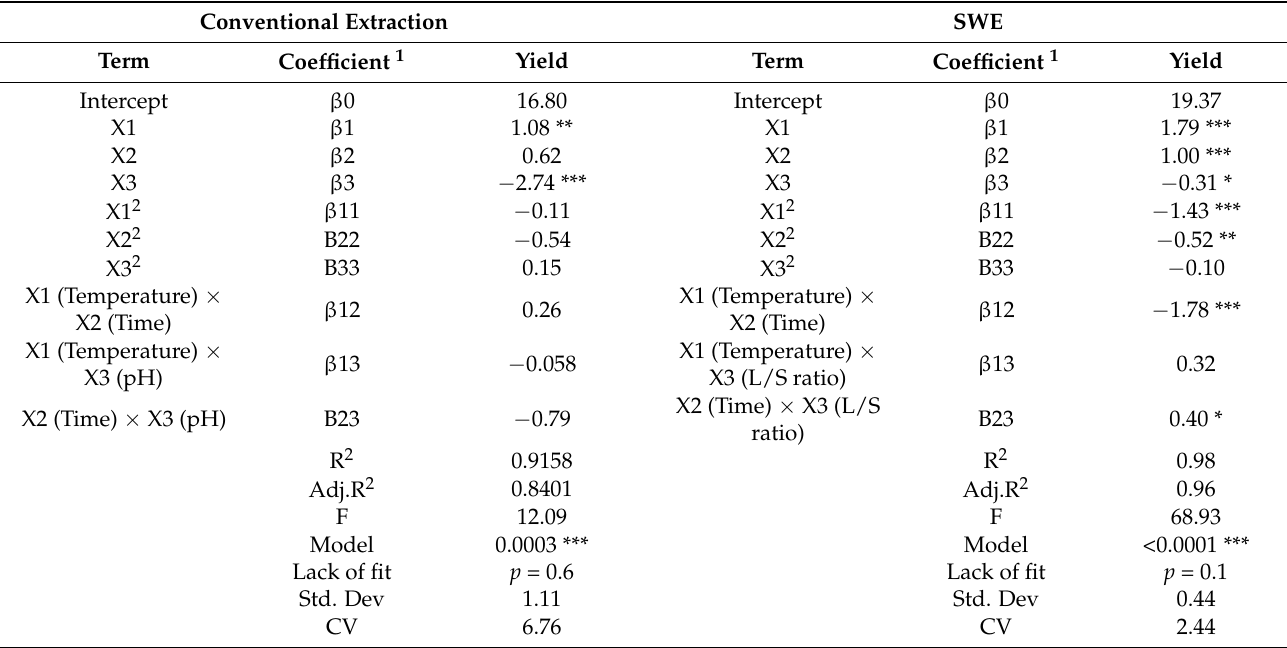
Table 1. Estimated regression coefficients for the model and the analysis of variance (ANOVA) for the experimental data of conventionally extracted pectin yield. Conventional Extraction SWE Term Coefficient